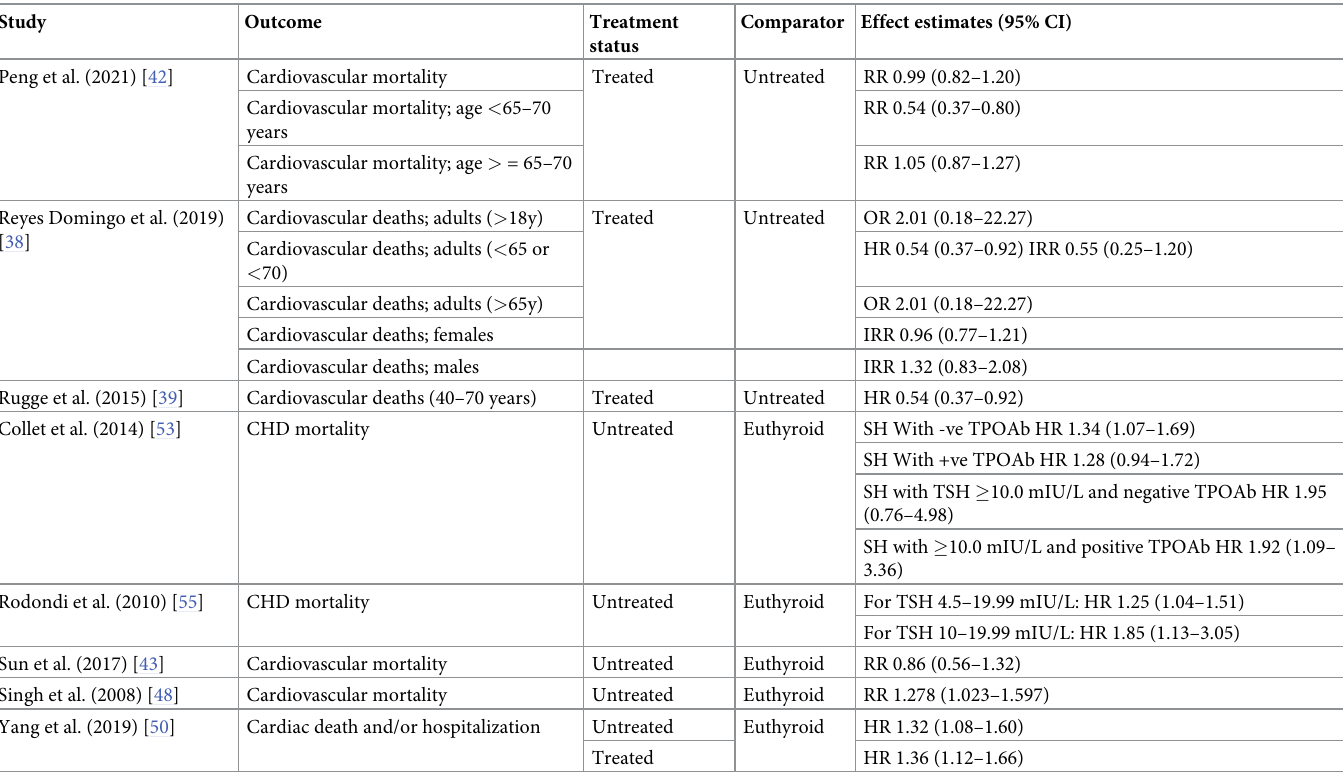
Table 5. Reported primary review findings on cardiovascular